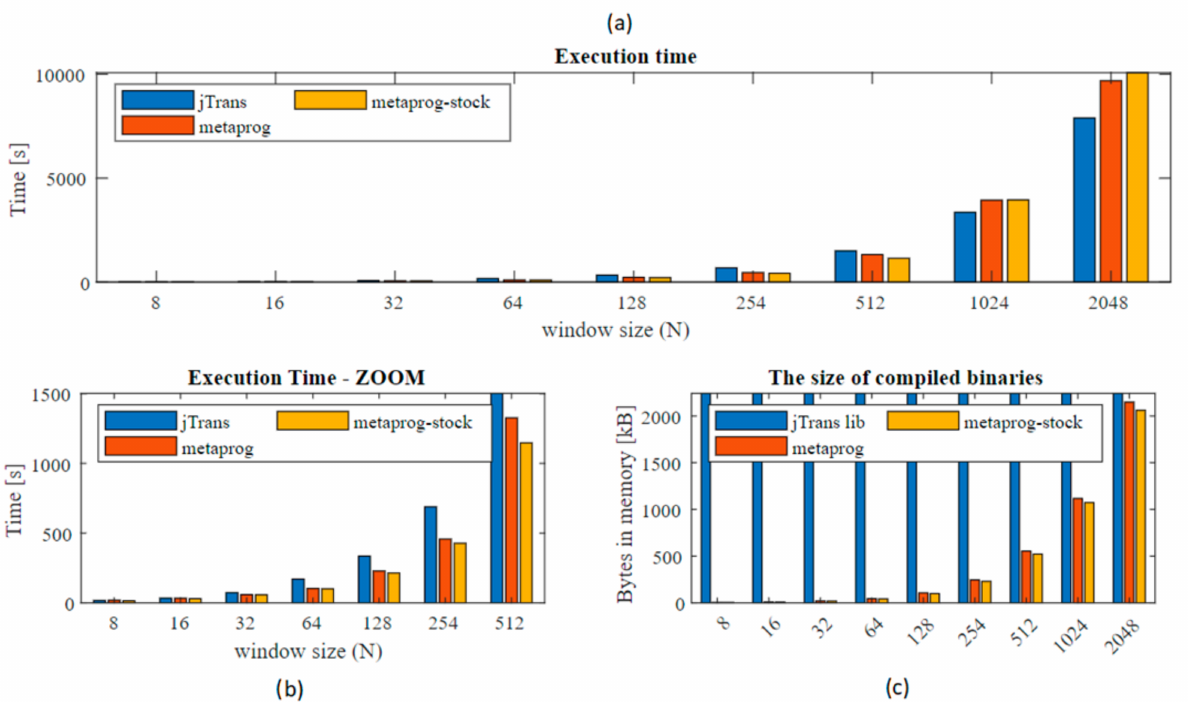
Figure 6. Comparison of execution time for jTransform library, metaprogram (metaprog), metaprogram with stockham extension (metaprog-stock). Analysis of compiled, generated binaries size. ( a ) execution times; ( b ) zoom for N = [8 . . . 512]. ( c ) The size of compiled, generated binaries for the analyzed algorithms.